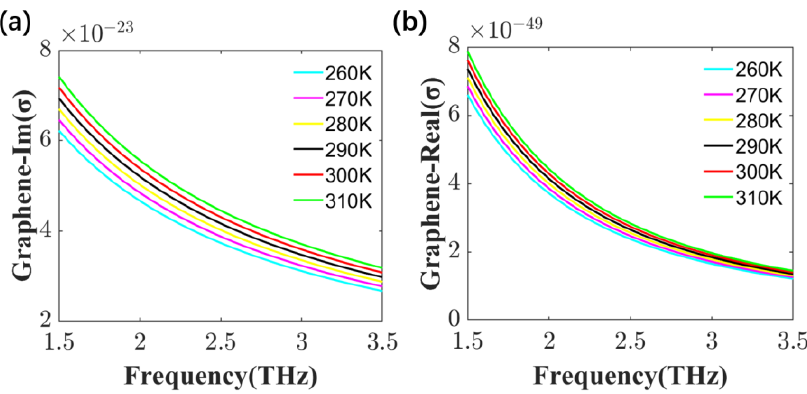
Figure 3. Real ( a ) and imaginary ( b ) parts of the intraband electrical conductivity of graphene at different temperatures.